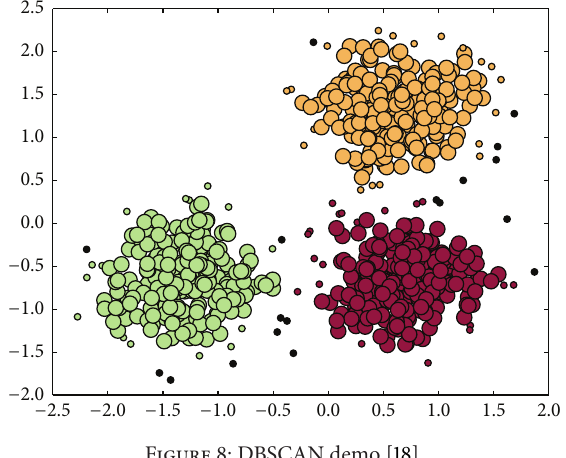
Figure 8: DBSCAN demo [18].